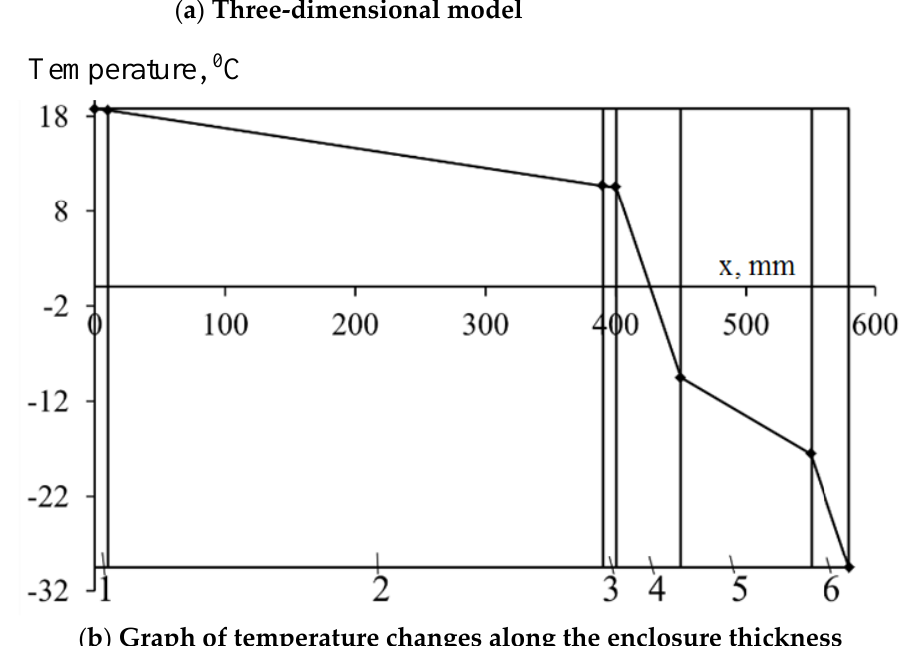
Figure 12. Temperature field in the enclosure at the absolute minimum ambient temperature: ( a ) — three-dimensional model; ( b ) — graph of temperature changes along the enclosure thickness: 1, 3 — cement-sand plaster; 2 — bearing layer from ceramic brick; 4 — insulant — extruded polystyrene foam; 5 — closed air gap.